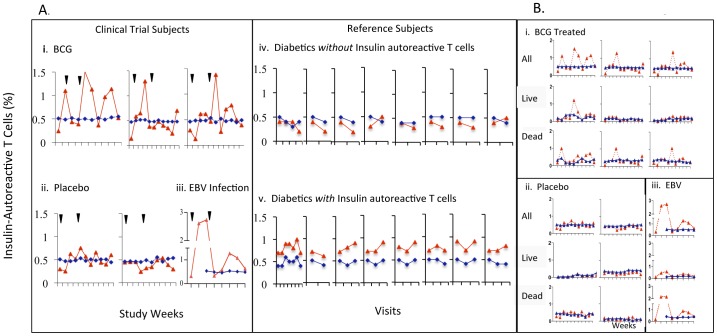
Insulin-autoreactive T-cells released into the circulation are dead after BCG treatment or EBV infection.(A) Percentage of insulin-autoreactive T-cells of total CD8 T-cells over 12 weeks for BCG-treated (Ai, Bi), placebo-treated, (Aii, Bii) and EBV-infected clinical trial subjects (Aiii, Biii). Reference diabetics without or with insulin-autoreactive T-cells vs. reference healthy controls (Aiv,v). (B) Insulin-autoreactive T-cells stratified by viability in clinical trial subjects. Red diamonds are long-term diabetics; blue diamonds paired healthy controls. Arrows are BCG or placebo injection times.